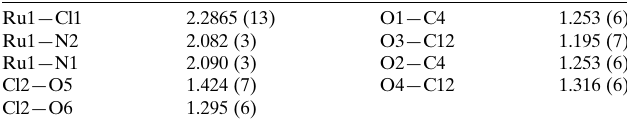
Table 1 Selected bond lengths (A˚ ).